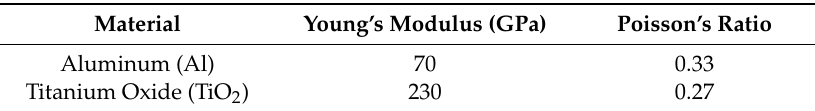
Table 3. Material